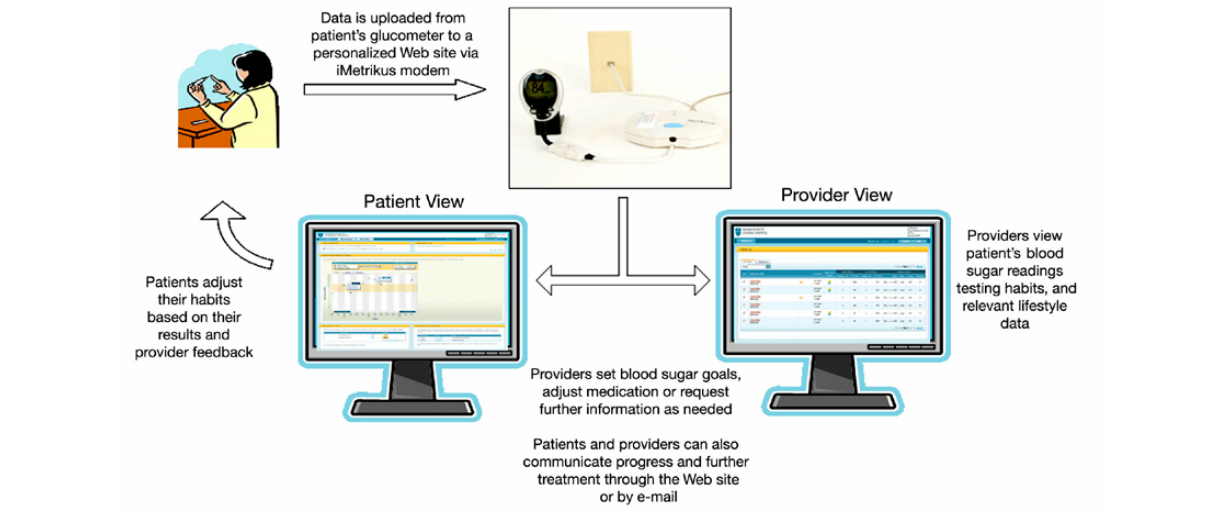
Figure 1. Diabetes Connect conceptual